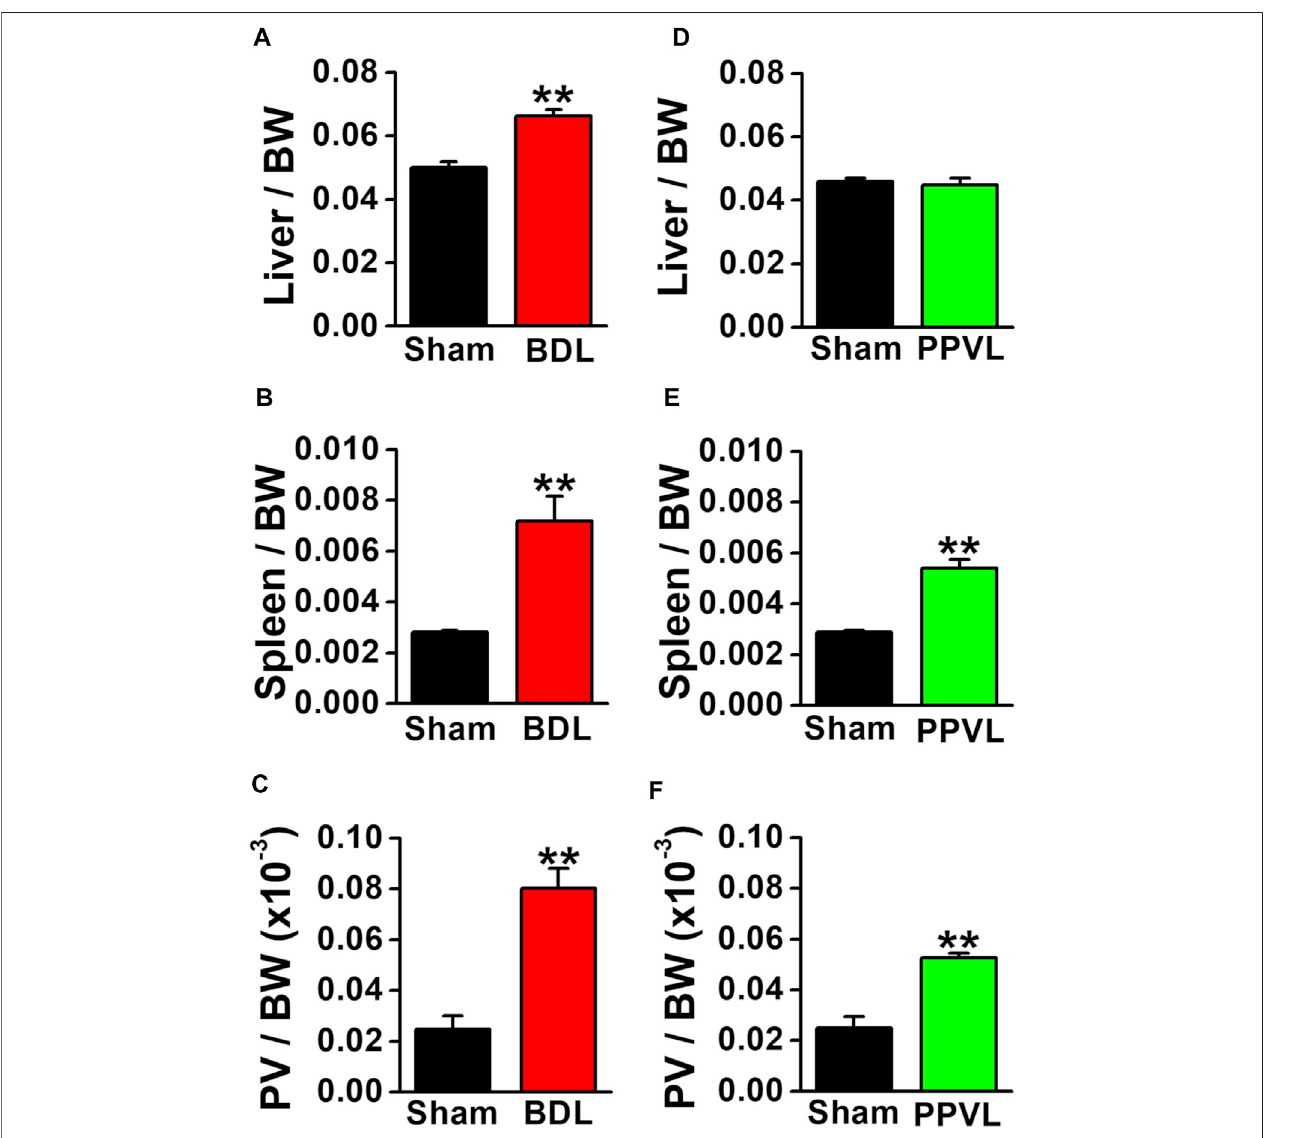
FIGURE1 | Macroscopic features of portal hypertensive mice. Twoportal hypertensive mice were used:BDL mice as aportal hypertensive model associated with cirrhosis and PPVL mice as an idiopathic portal hypertensive model independently of cirrhosis. Wet tissue weights of portal hypertensive mice were measured and normalized by body weight (BW). (A) Liver weight in sham-operated and BDL mice ( n = 12). (B) Spleen weight in sham-operated and BDL mice ( n = 12 – 13). (C) Portal vein (PV) weight (5 mm long) in sham-operated and BDL mice ( n = 5). (D) Liver weight in sham-operated and PPVL mice ( n = 8 – 12). (E) Spleen weight in sham- operated and PPVL mice ( n = 12 – 13). (F) Portal vein weight in sham-operated and PPVL mice ( n = 3). Data are presented as means ± S.E. ** p < 0.01 versus sham.